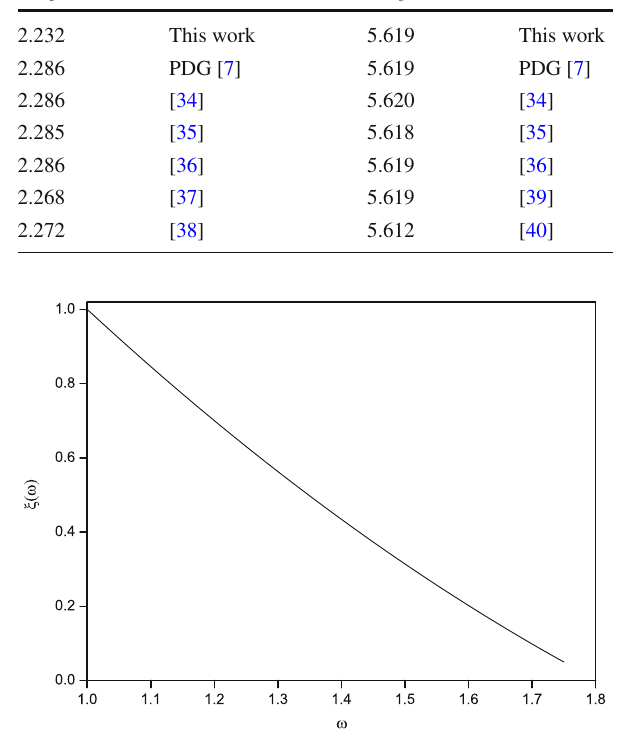
Fig. 1 The Isgur-Wise function ( ξ(ω) ) for the Λ b → Λ c (cid:3) ¯ ν semilep- tonic decay